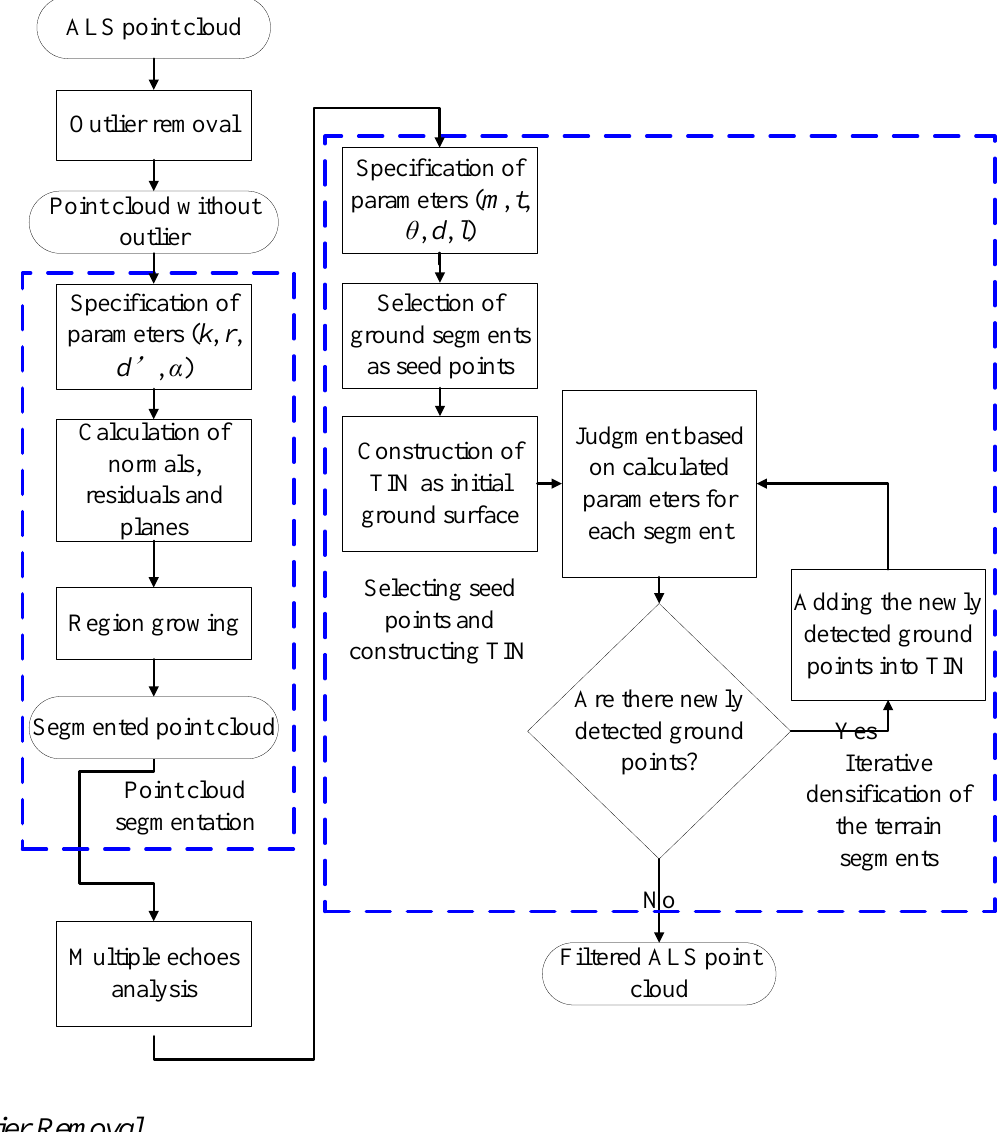
Figure 2. Flow chart of the segmentation-based filtering (SBF)